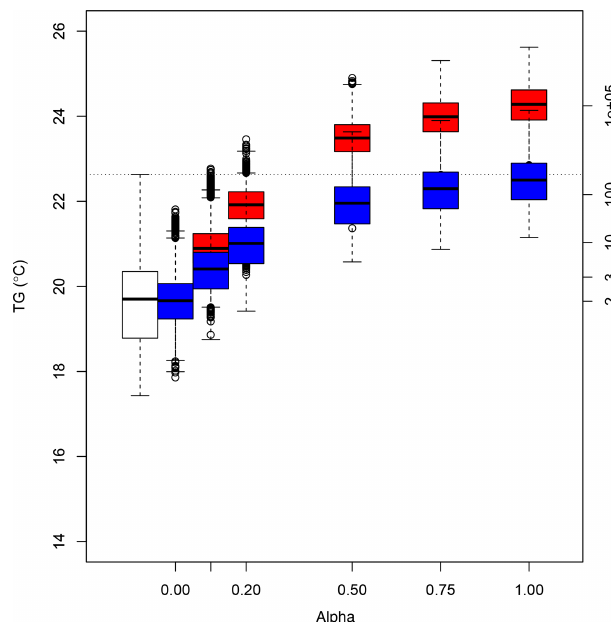
Figure 5. Box plots of simulated June–July–August (JJA) temper- atures (TG in degrees Celsius) as a function of the parameter α for all years. The boxes of box plots indicate the median ( q 50 ), lower ( q 25 ) and upper ( q 75 ) quartiles of the simulated values. The up- per whiskers indicate min [ max (T ), 1 . 5 × (q 75 − q 25 ) ] . The lower whisker has a symmetric formulation. The points are the simulated values that are above or below the defined whiskers.The axis on the right indicates return times (in years), assuming a Gaussian distri- bution of JJA temperature averages with parameters estimated from the white box plot. The horizontal dotted line is the mean TG in